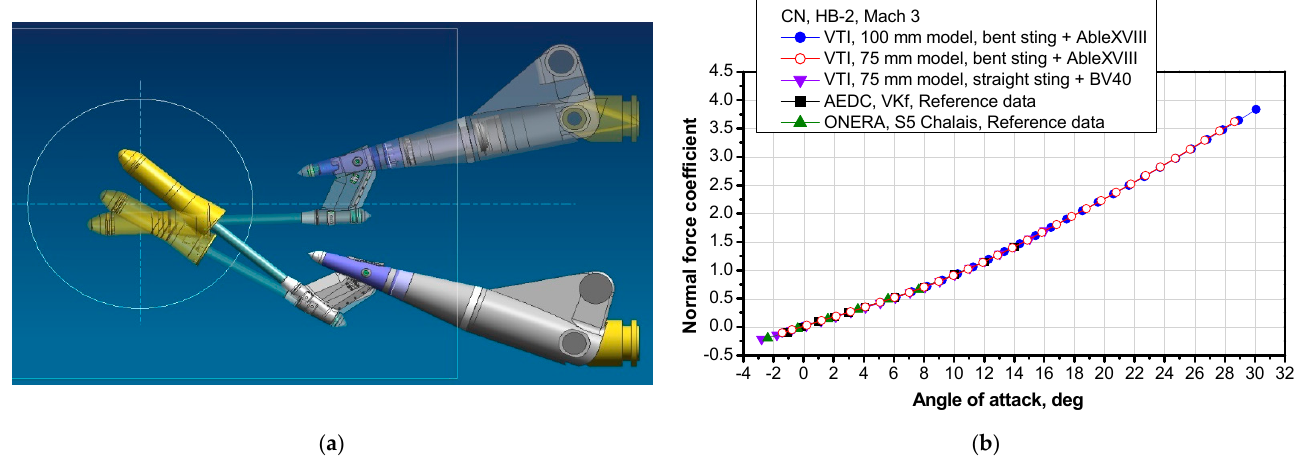
Figure 15. ( a ) CAD rendering of the 100 mm diameter HB − 2 model on the bent sting used in the tests at extreme AoA [47]; ( b ) Mach 3 results of HB − 2 models obtained in the T-38 wind tunnel with the models on two stings and balances, correlated with available results from AEDC (up to +14 ° ) and ONERA (up to +8 ° ) [40,41,55].